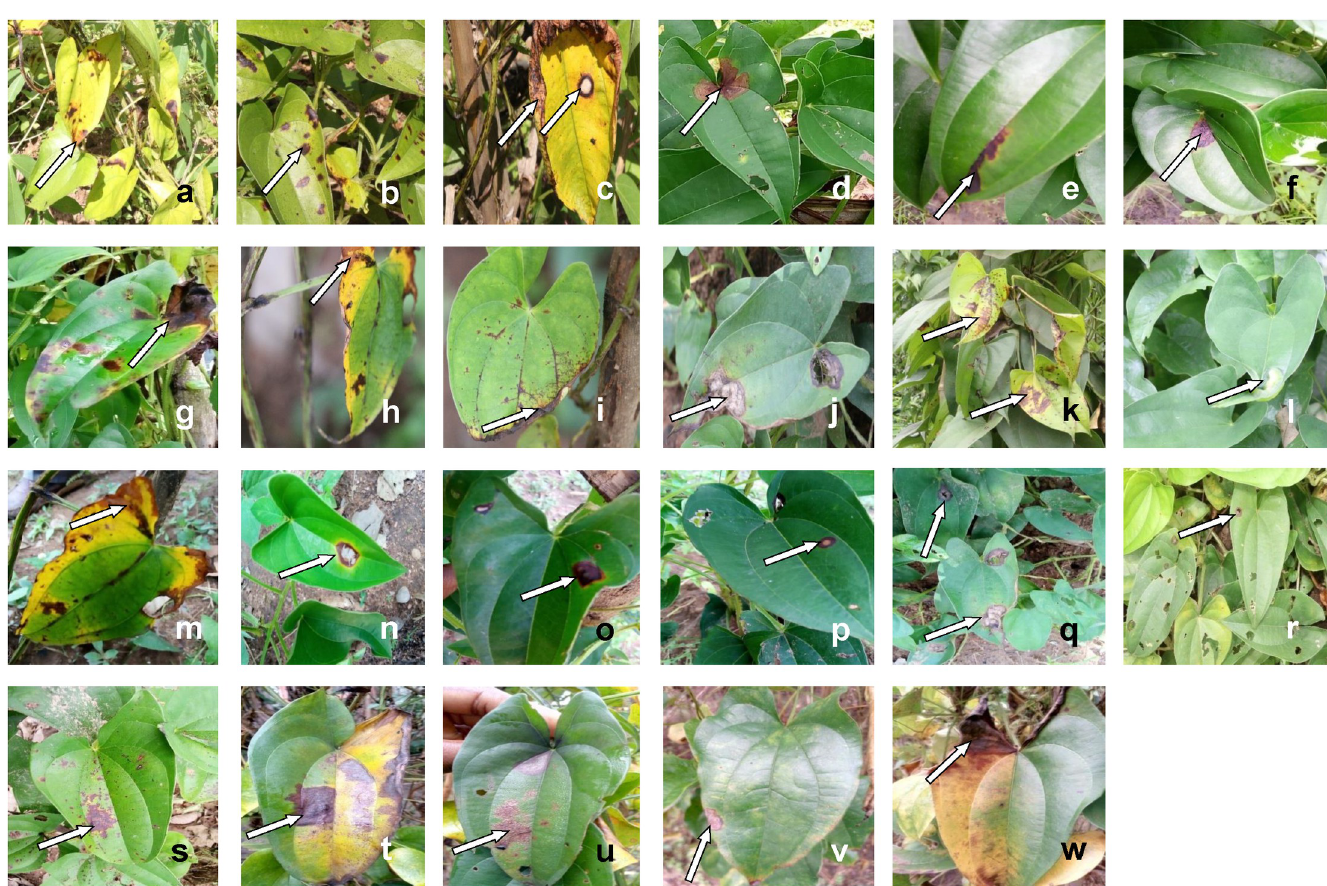
Fig 1. Variation in appearance of anthracnose symptoms sampled on D . alata and D . rotundata in all the locations. Infected leaves sampled from Obubra sampling area (a-d), Yakurr (e-l), Ogoja (k-q); Ikom (r-s), Akpabuyo (t-u), and Calabar South (v-x). Arrow indicates symptoms.